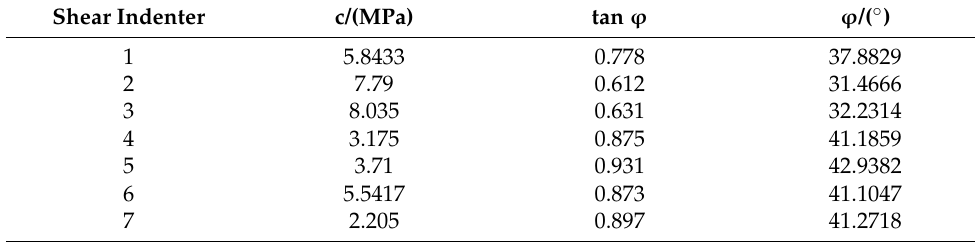
Figure 5. The strength curve of seven shear indenters. Table 3. Values of c and φ measured for seven shear indenters.